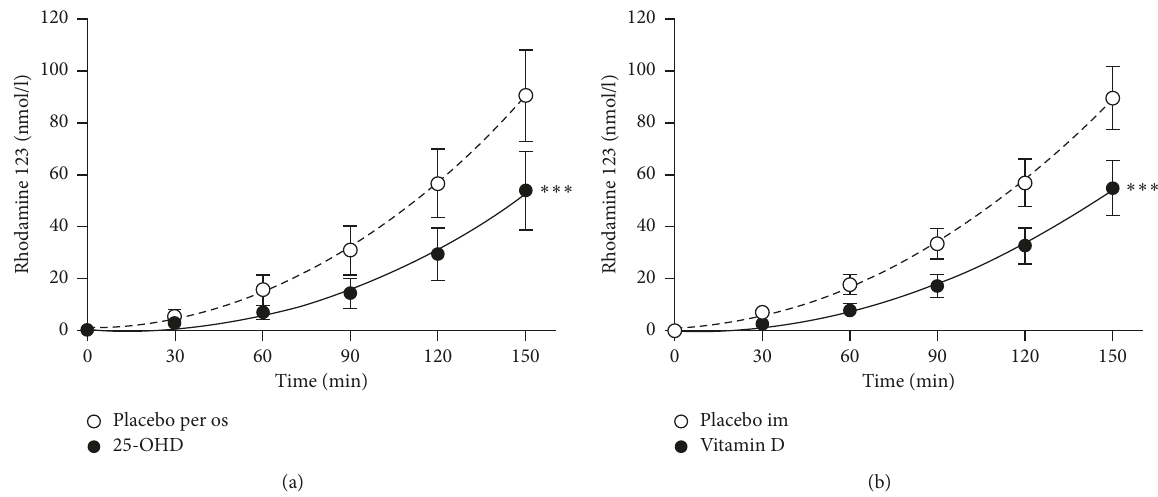
Figure 2: Net increase in the mucosal concentration of rhodamine-123 (minus increase in serosal concentration) after inhibition of rhodamine-123 transport by addition of verapamil to the mucosal compartment. Given are results obtained with ileal preparations of rats treated with 6 μ g 25-hydroxyvitamin D3 (25-OHD 3 ) per kg BW per os daily for 10days or 300 μ g vitamin D 3 per kg BW intramuscularly once 10days before